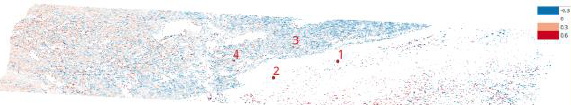
Figure 9. Descending track-Sept.11-22: Interferogram after filtration, (Hlaváčová, 2015)